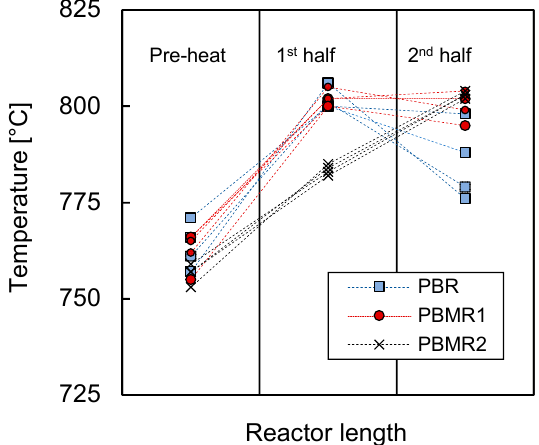
Figure 8. Temperature distribution in the reaction bed for all the experiments carried out in this work, divided according to PBR, PBMR1, and PBMR2.